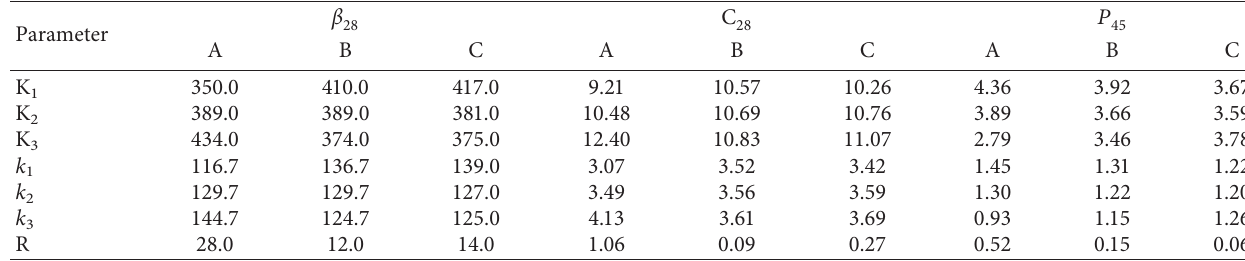
Table 8: Results of range analysis.